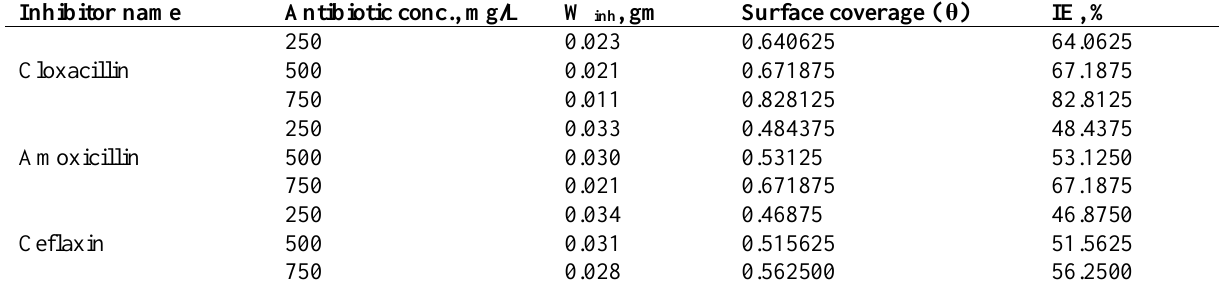
Weight loss results of the three bioactive inhibitors. [W free = 0.064 gm]